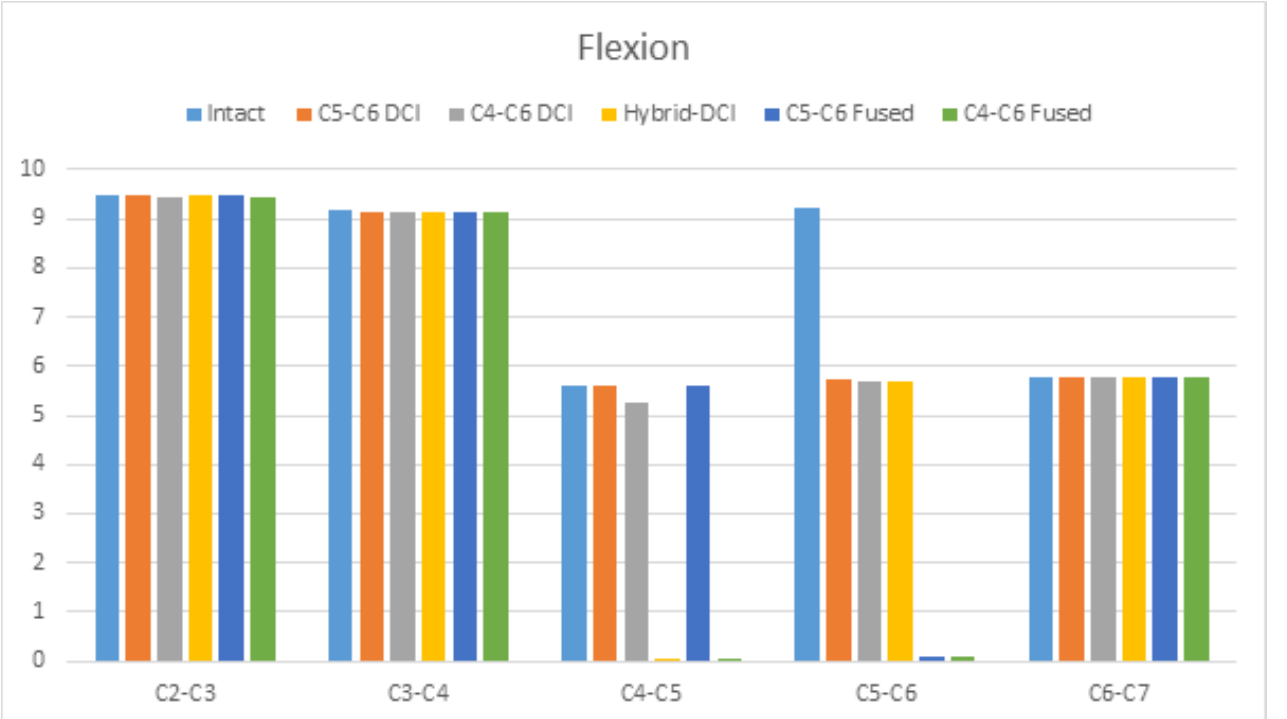
Figure 4. The comparison of the ranges of motion (ROMs) during flexion among the C5–C6 DCI, C4–C6 DCI, hybrid DCI, C5–C6 ‐ fused, and C4–C6 fused models. The vertical axis shows ROMs in degrees.